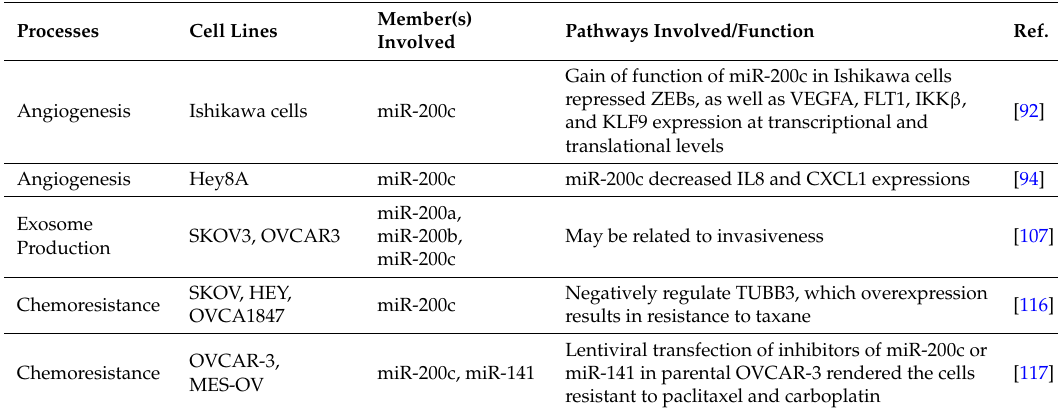
Table 2. Other functions of miR-200s in ovarian and gynecologic